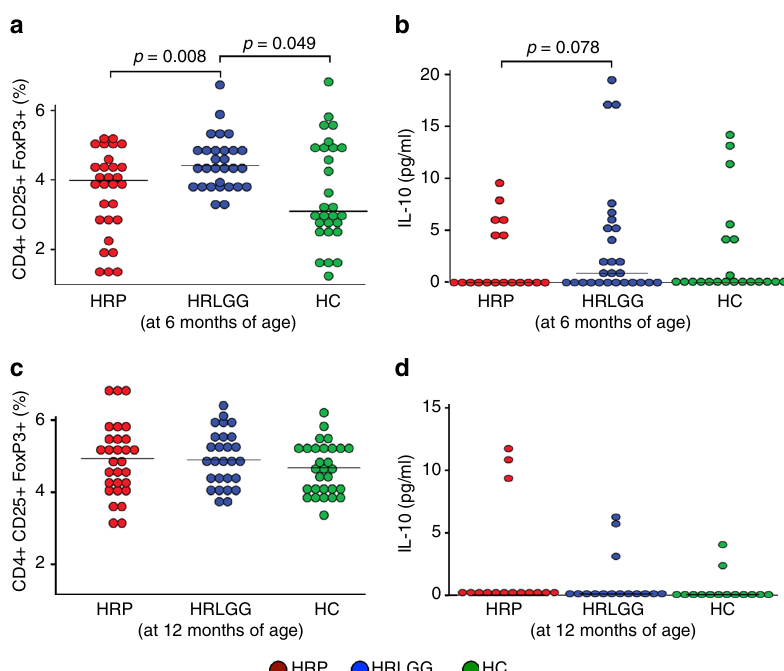
Fig. 4 Lactobacillus rhamnosus (LGG)-associated fecal products promote T reg cell expansion and IL10 production ex vivo at 6 months of age. Sterile fecal water derived from 6-month-old LGG-supplemented high risk for asthma (HRLGG; n = 5) stool induced an increase in the proportion of a . T reg cells and b . IL10, compared with high risk for asthma placebo (HRP; n = 5) or healthy (HC; n = 5) participants. At 12 months of age, 6 months following cessation of LGG supplementation, no difference in the proportion of c . T reg cells or d . IL10 expression was observed between the three groups. Linear mixed effects (LME) adjusted for blood-donor was used to test for between group